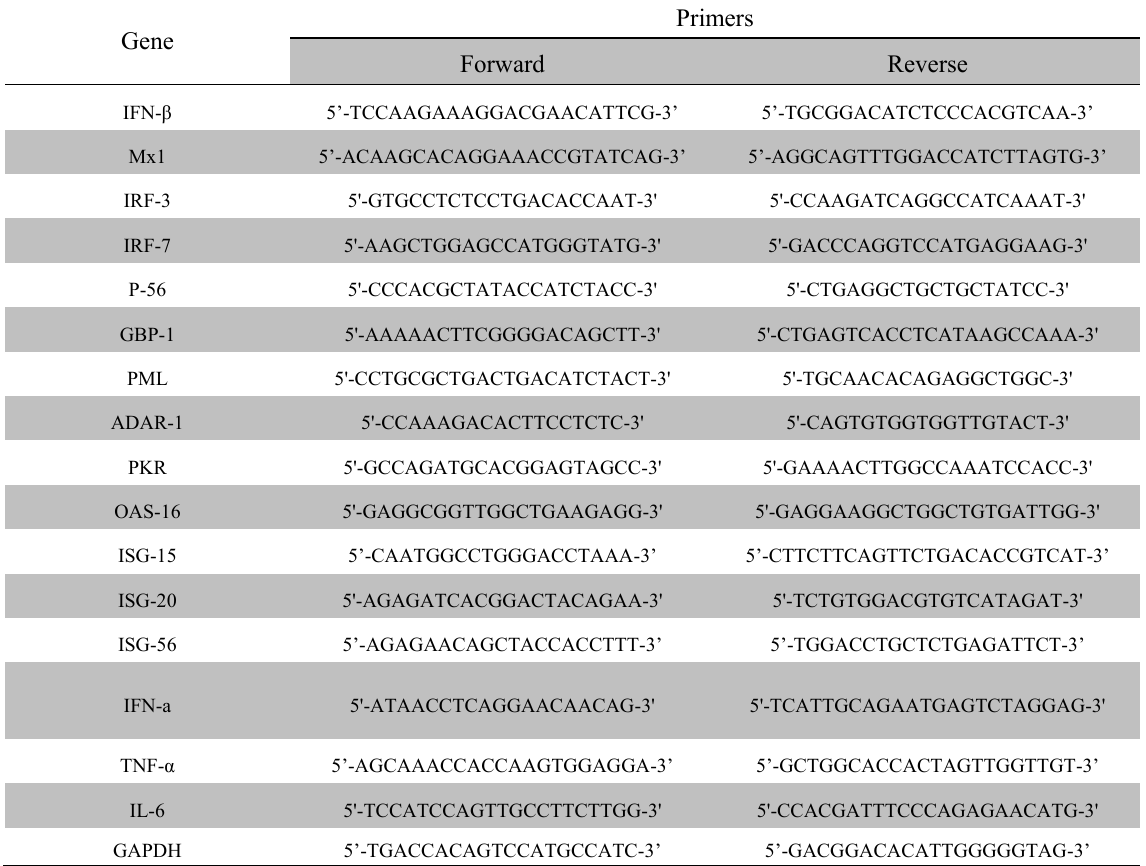
Table 2. Mouse primer sets used to confirm mRNA expression.